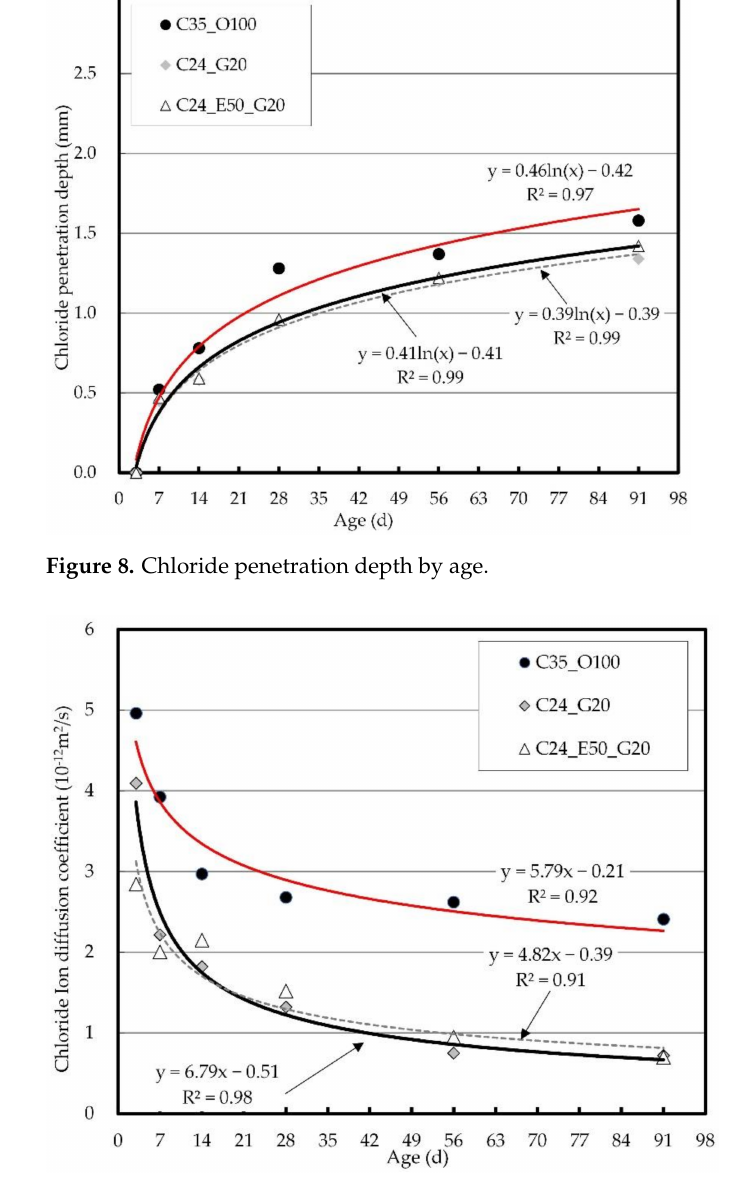
Figure 9. Chloride ion diffusion coefficient by